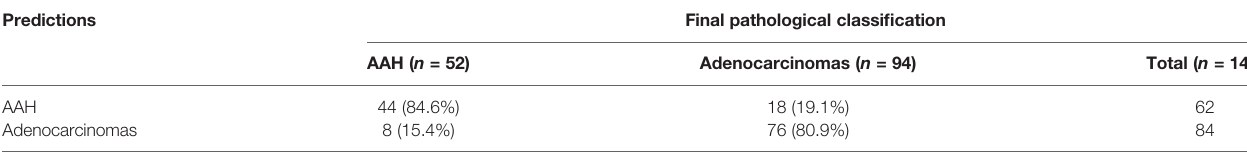
TABLE 2 | Confusion matrix of the prediction results obtained from the validation set by the prediction model. Predictions